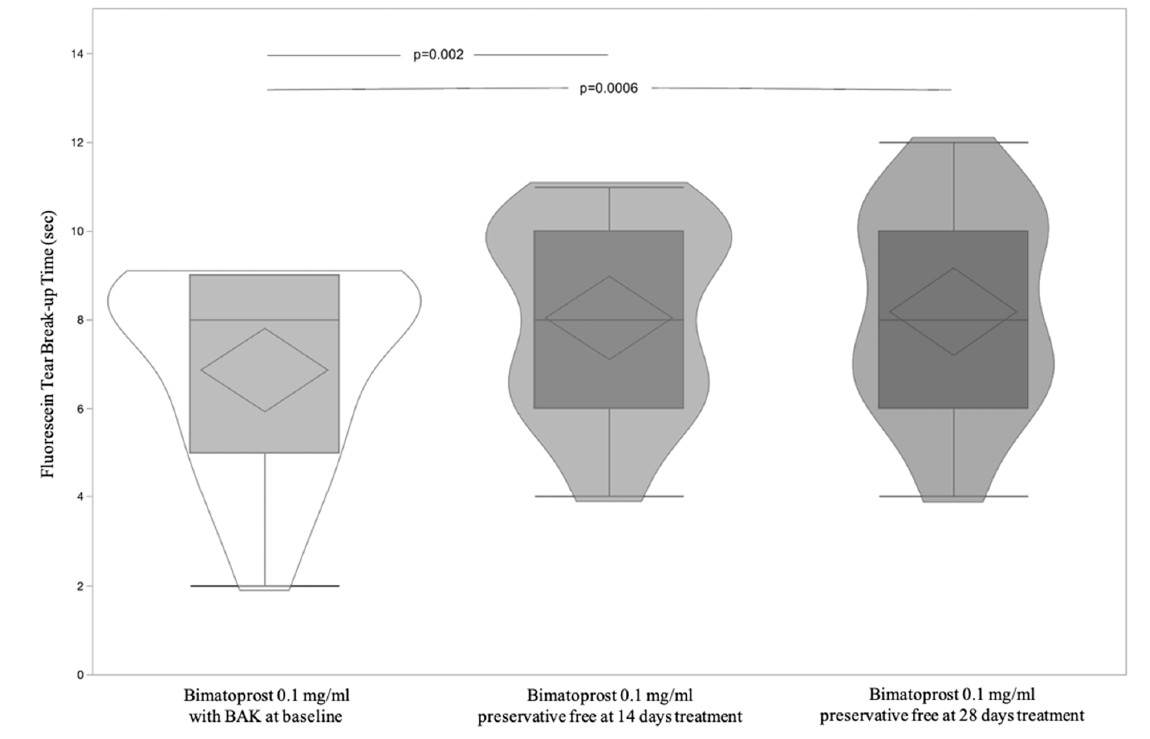
Figure 2. Violin and box-plots of the ocular surface index by Bimatoprost 0.1 mg/mL with BAK at baseline and the Bimatoprost 0.1 mg/mL preservative-free at 14 and 28 days.